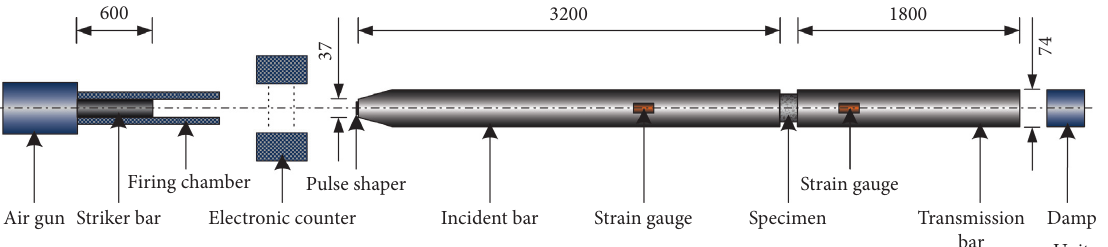
Figure 2: Diagram of the split Hopkinson pressure bar test.